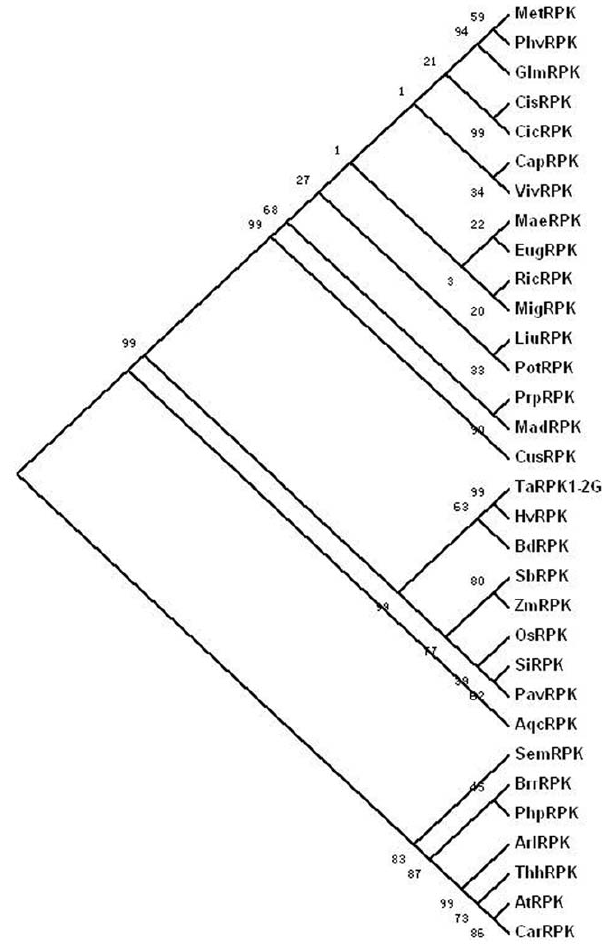
Figure 4. Phylogenetic tree of TaRPK1-2G and its orthologs. Neighbor Joining phylogenetic tree of the kinase domains of TaRPK1- 2G and its orthologs from other 31 plant species was constructed using MEGA4.1. Bootstrap support on the left of each node was inferred from 1,000 replicates. The full names of all species and accession number or locus name of each sequence used for phylogenetic analysis were provided in Form S1.